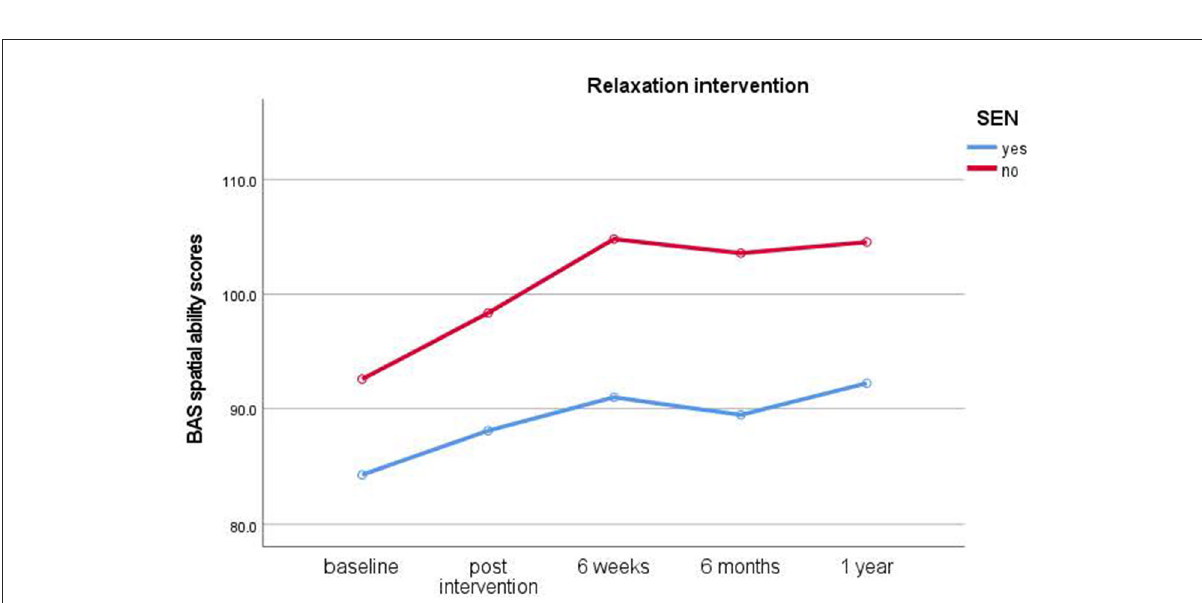
FIGURE3 Results of longitudinal assessments in the relaxation intervention: means for British Ability Scale spatial ability scores (y-axis) over time (x-axis) in the relaxation intervention group for children with and without special educational needs (SEN). Higher scores imply higher